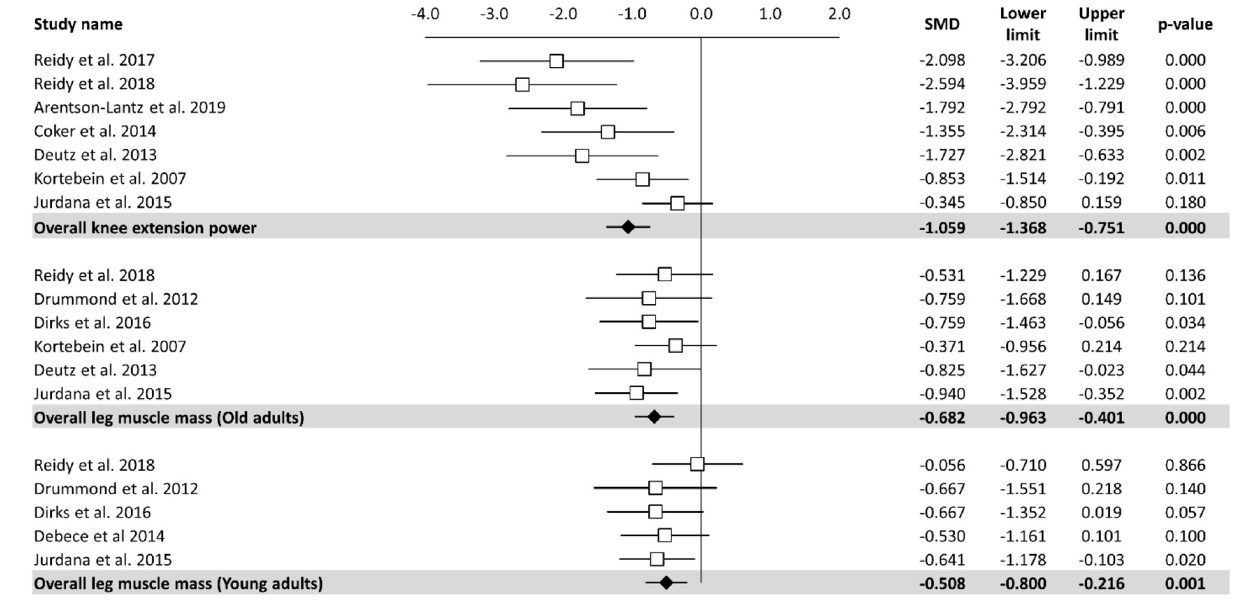
p = 672). Heterogeneity among included studies was rated as moderate ( I 2 =